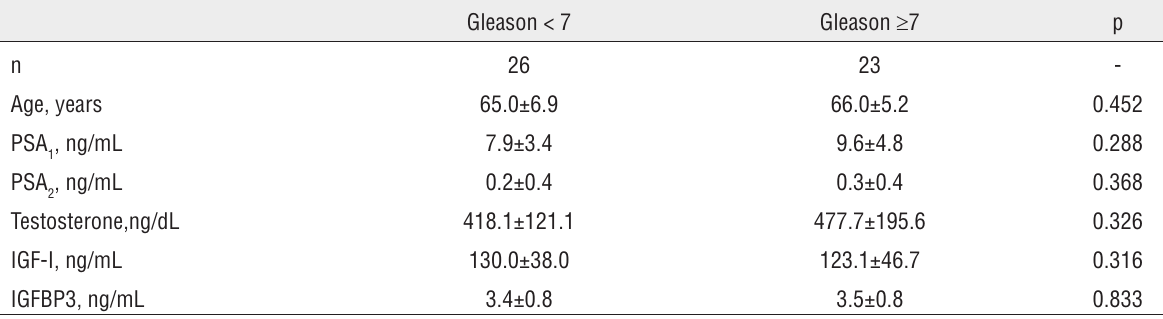
Table 2 - Clinical and laboratorial characteristics of PCa cases according to Gleason